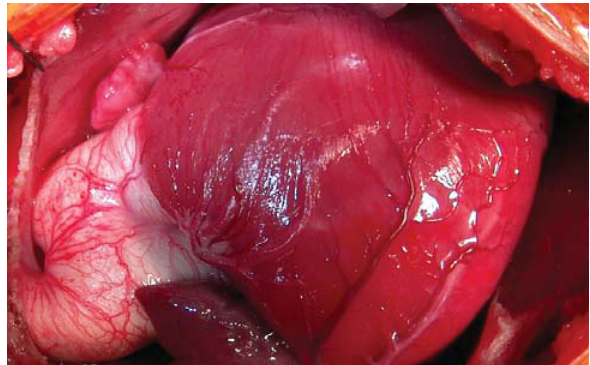
(pinças)Fig. 3 – Aspecto inicial evidenciando externamente a comunicação (janela) existente entre a aorta ascendente e o tronco